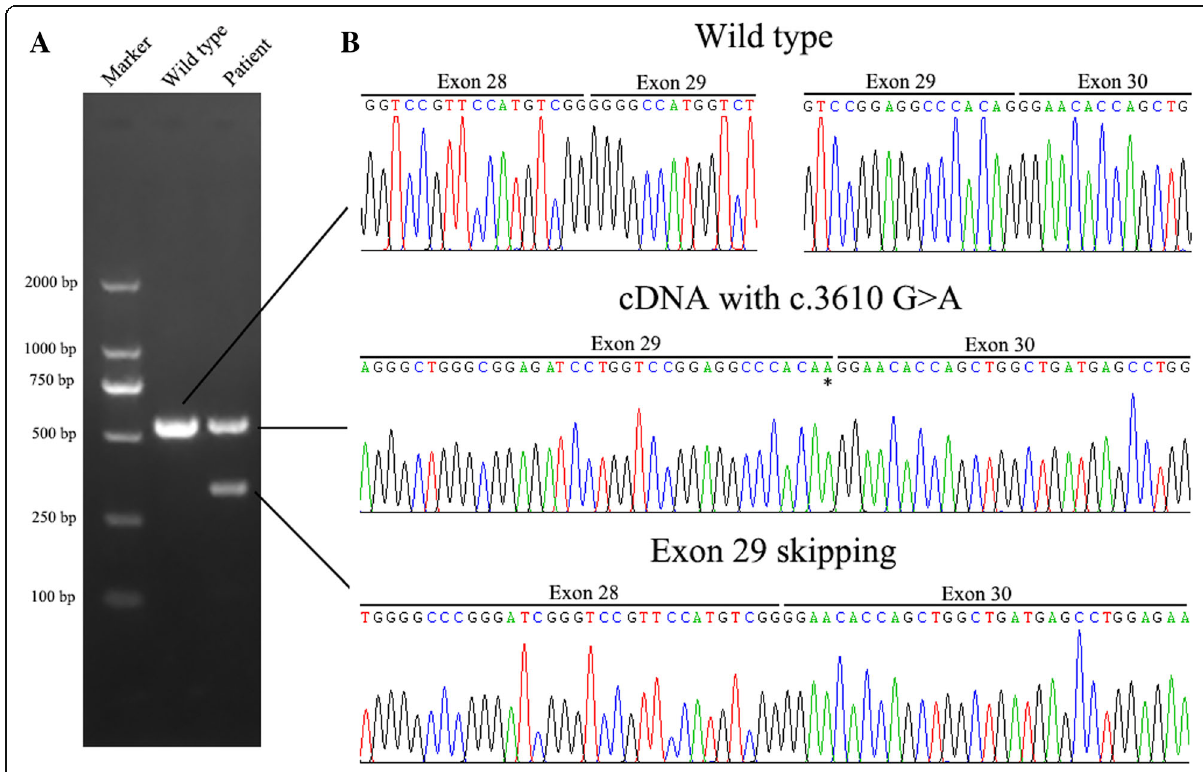
Fig. 7 RNA analysis. a Electrophoresis for amplification of TSC2 cDNA in the proband and a normal person. b Sequencing chromatogram of TSC2 cDNA in the proband and a normal person. Upper panel, wild type; Middle panel, transcripts with missense mutation c.3610G > A; Lower panel, transcripts lacking exon 29. The asterisk indicated the position of mutation (c.3610G> A) of exon 29 in